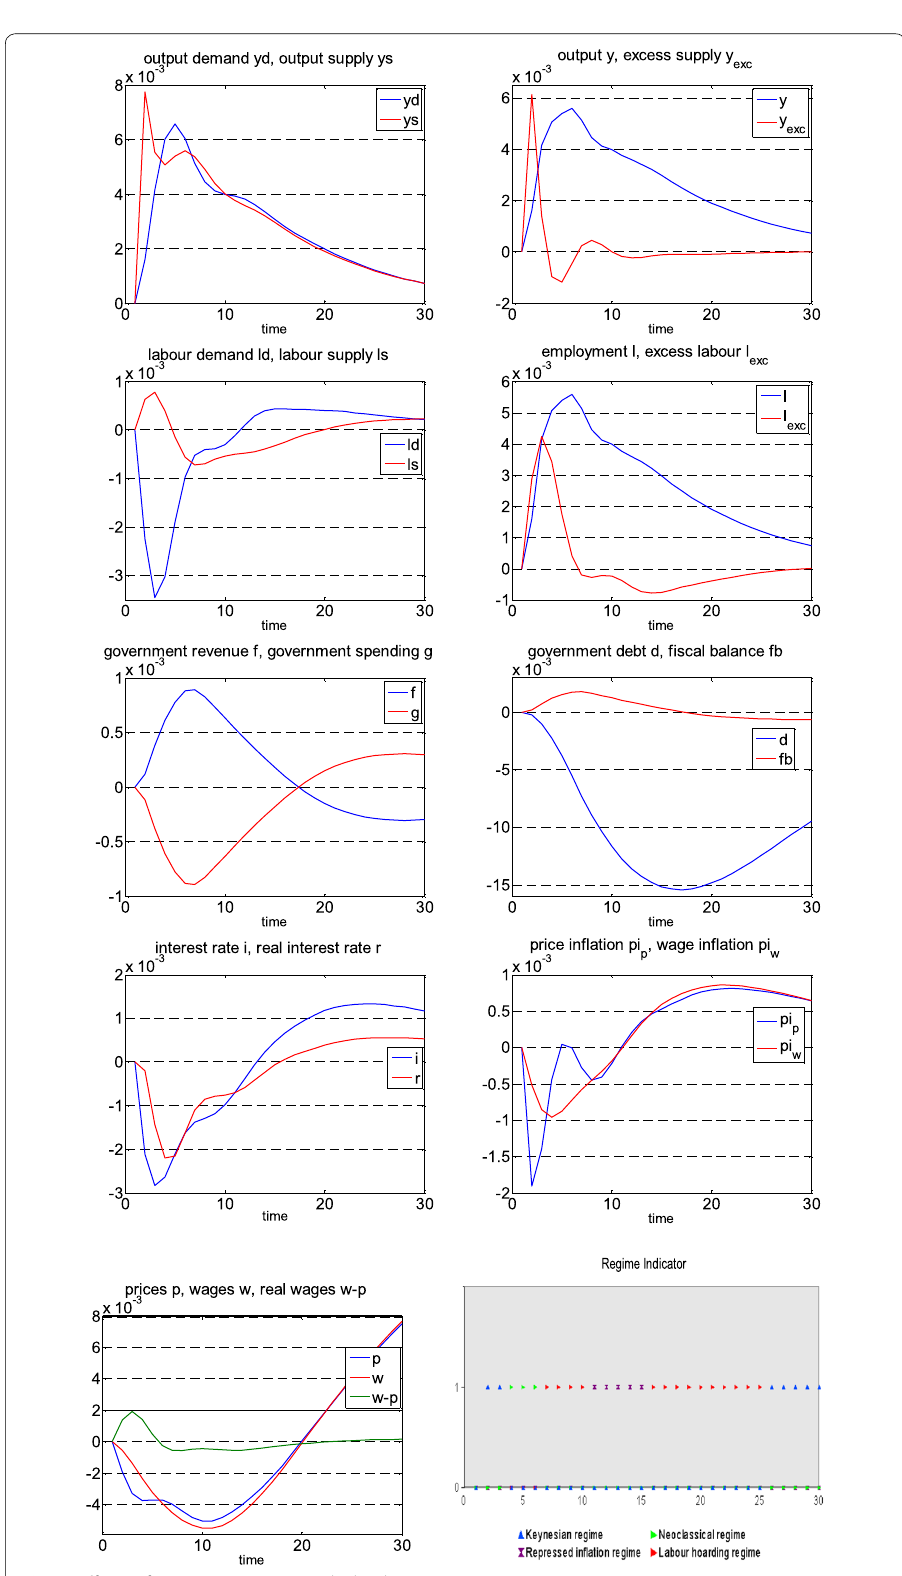
Fig. 4 Effects of a persistent TFP growth